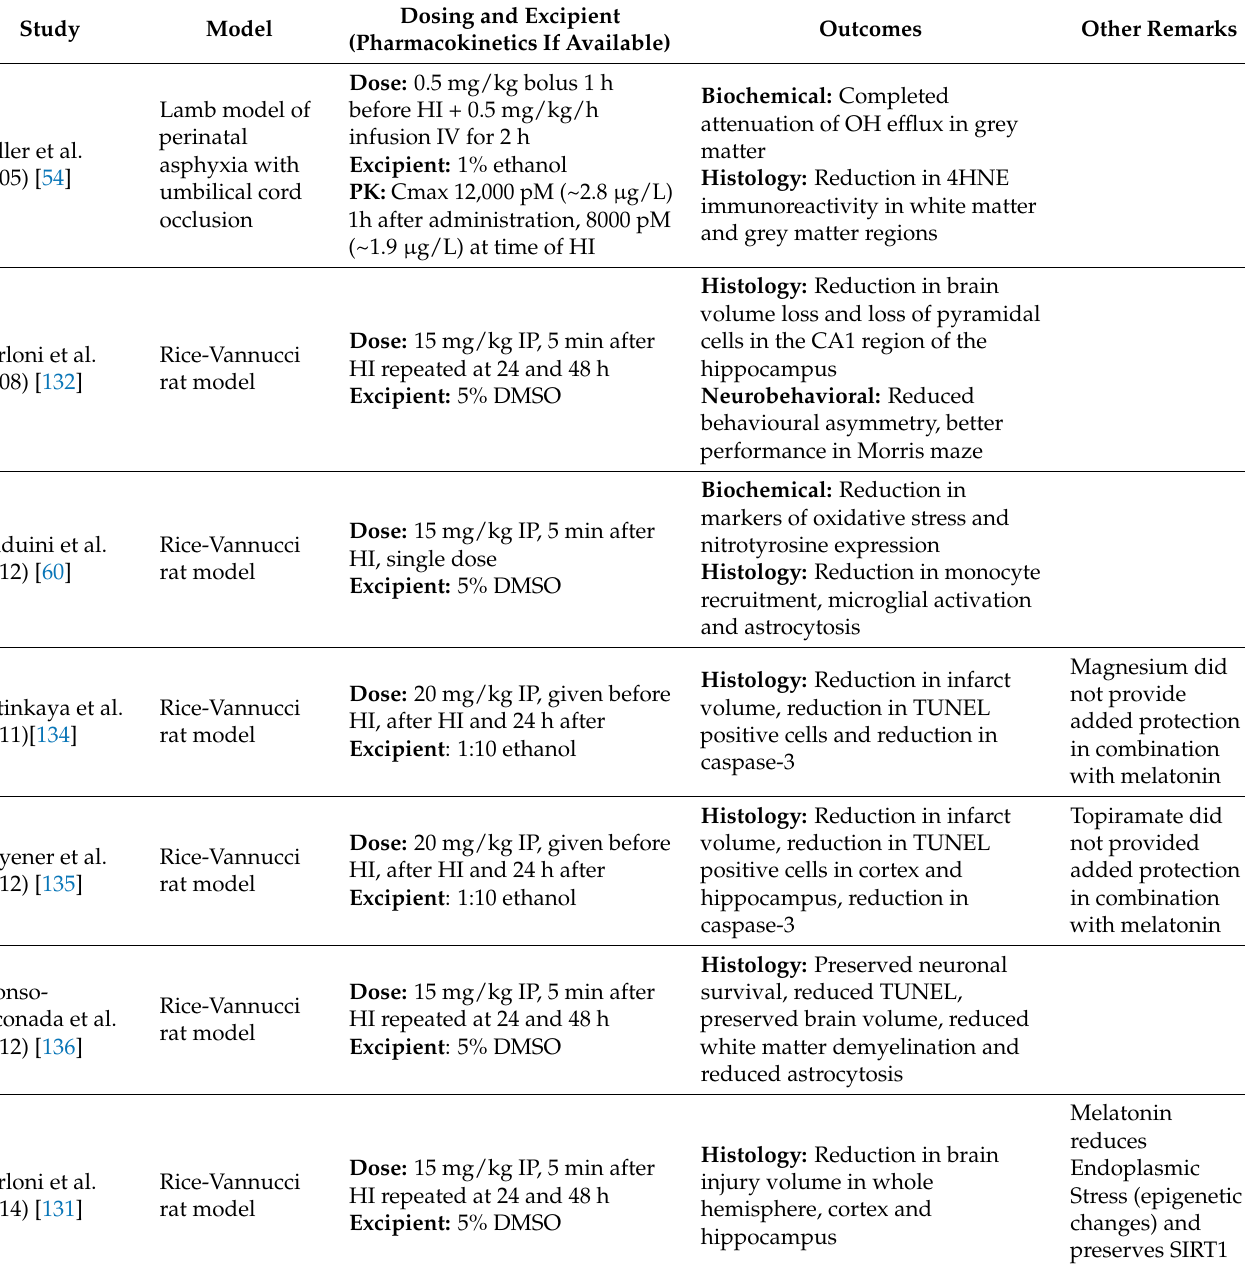
Table 2. Animal studies assessing melatonin as a single agent for neonatal